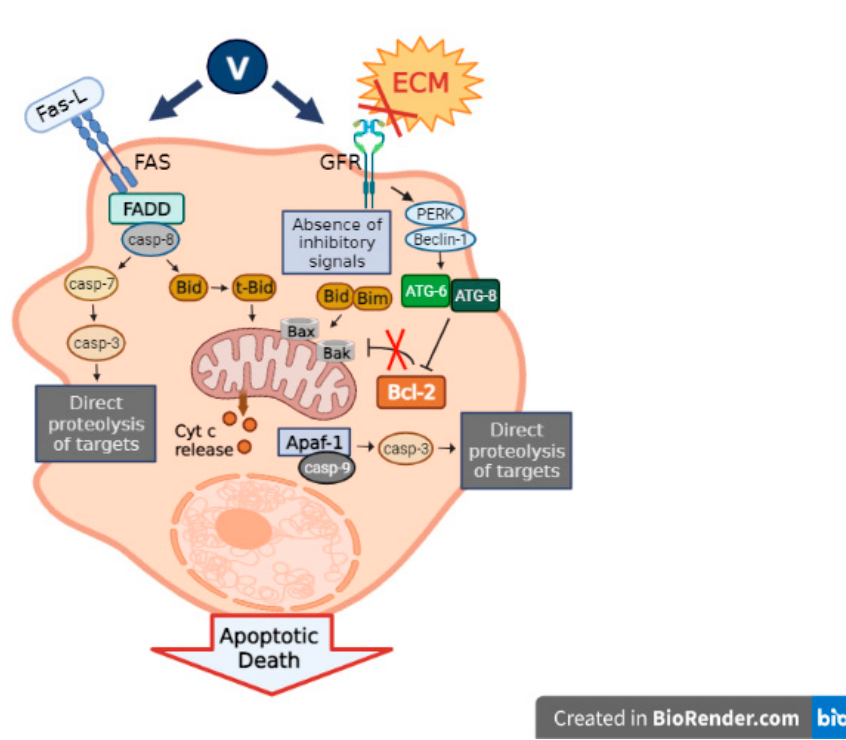
Figure 2. Apoptosis cell pathways activated by vanadium compounds. Adapted from [43].